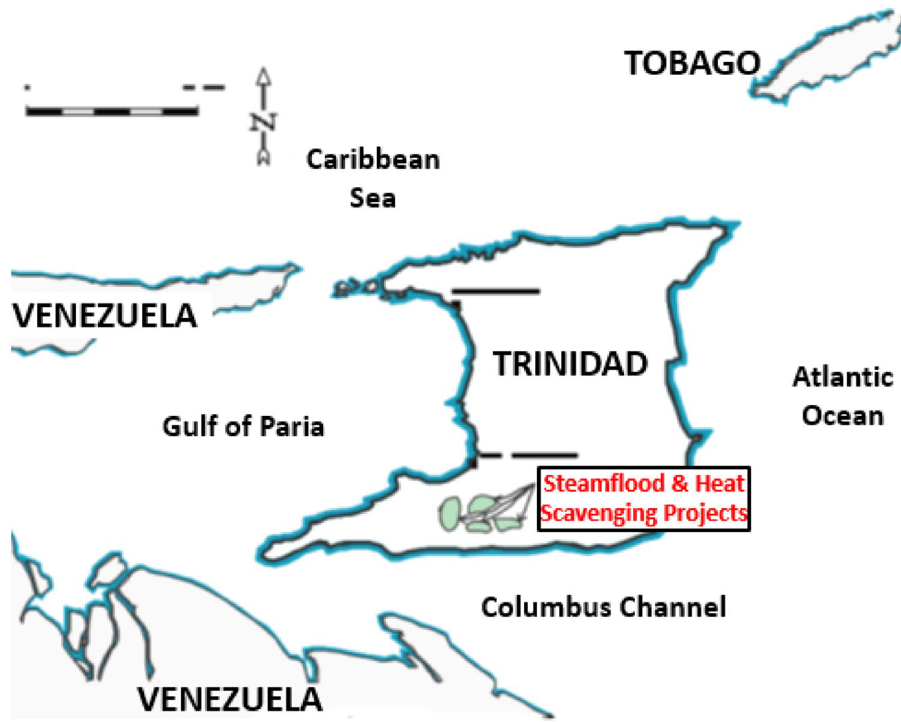
Fig. 1 Petrotrin thermal map depicting the location of the Cruse ‘E’ field (adapted from Ramlal 2004)